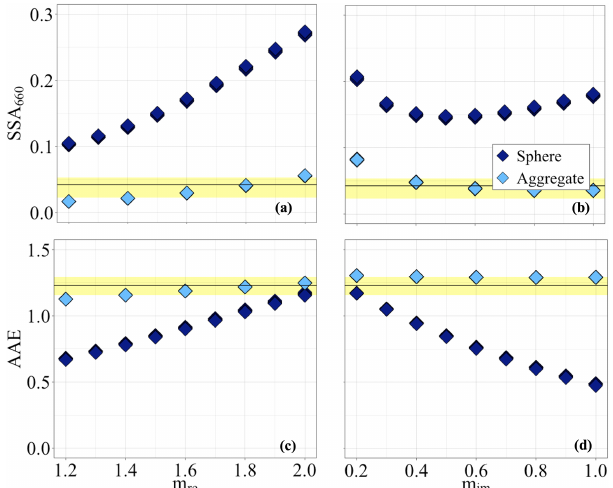
Figure 7. Optical properties of bare BC particles studied as a func- tion of the real part and imaginary part of the complex refrac- tive index ( m re and m im ). The results are shown for SSA (a, b) and AAE (c, d) for case III ( d p , VED = 160nm) of E1 using both “sphere” and “aggregate” representations. The yellow area in the figure represents the experimentally measured values, and the dashed line is the mean measured value for each case. Panels (a) and (c) are defined by fixed imaginary parts, while panels (b) and (d) are defined by fixed real parts according to Table